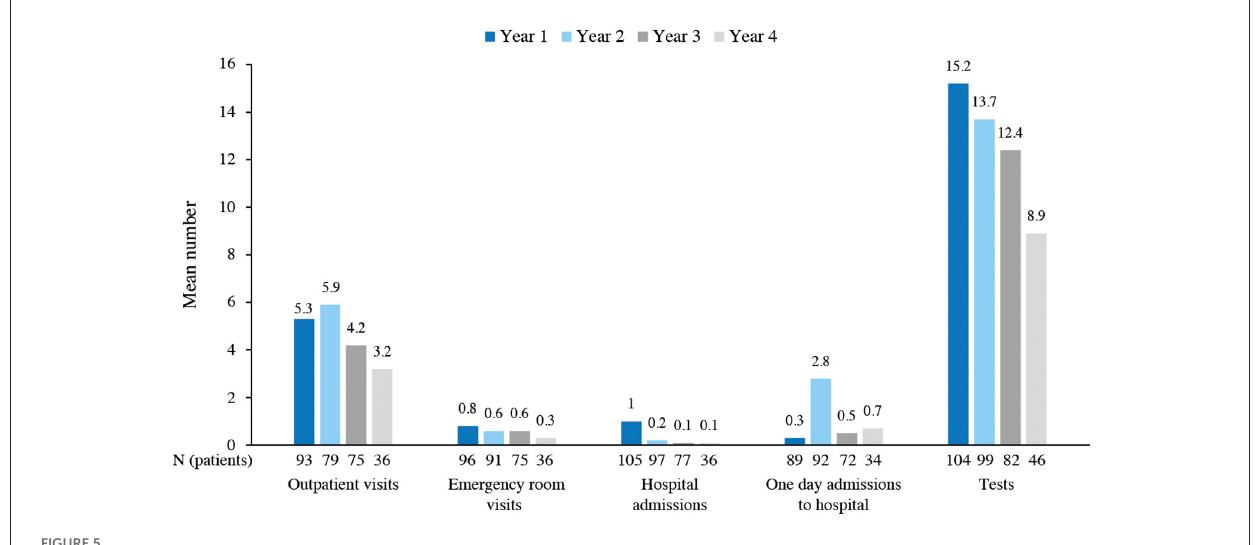
FIGURE5 Healthcare resource use during alemtuzumab